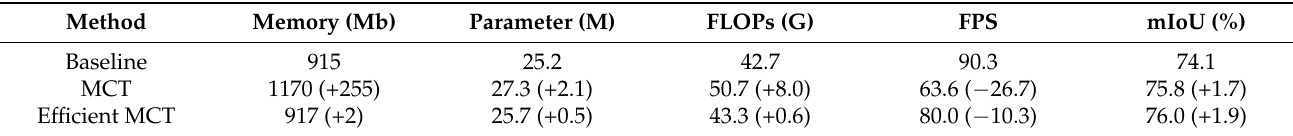
Table 4. Ablation study on computation cost.